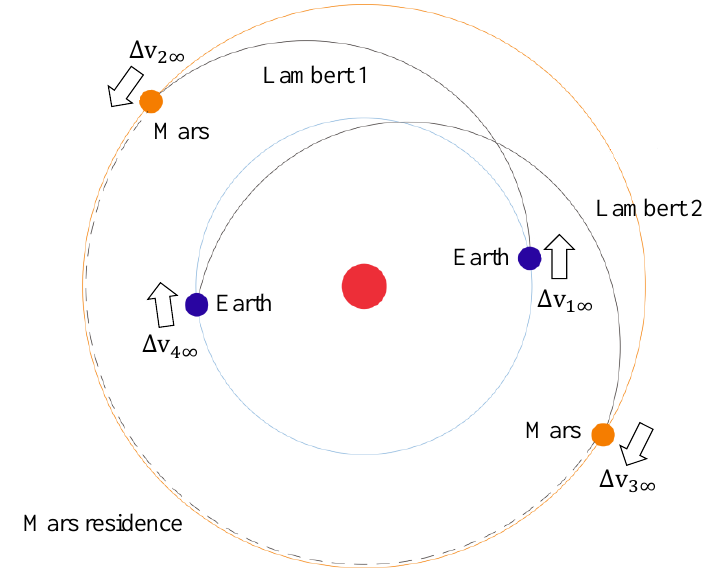
Figure 4. Mission profile for impulse maneuver transfers (Lambert transfers) in heliocentric coordi- nate system.